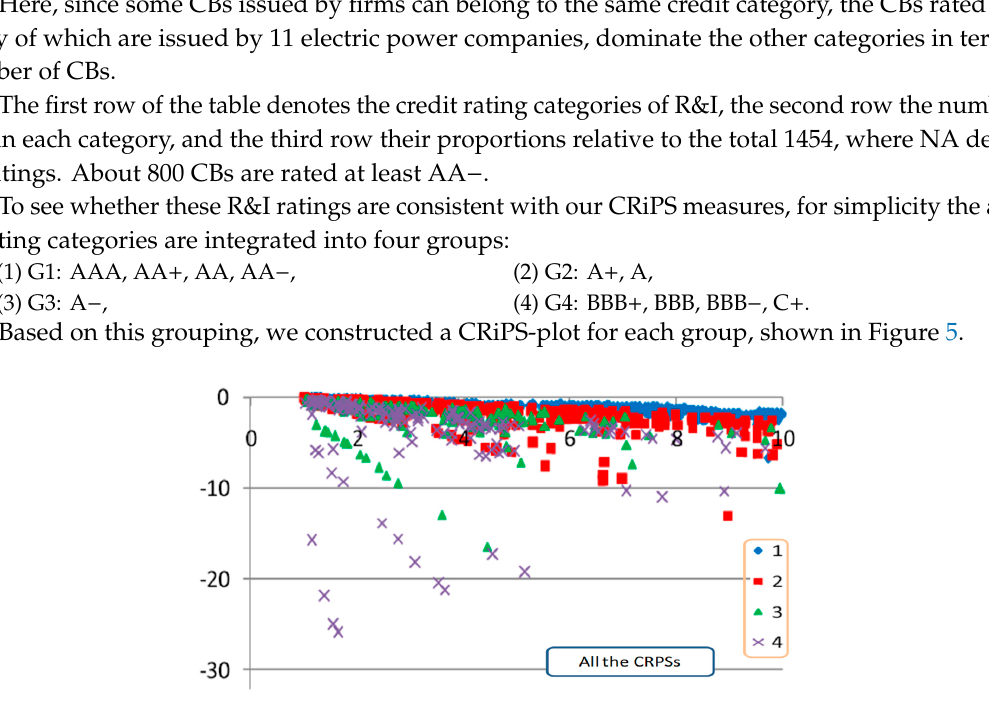
Figure 5. CRiPS-plot of the Japan Rating & Investment Information Center (R&I) credit rating groups in the plane （ ( ) kM k s ， k y ） .